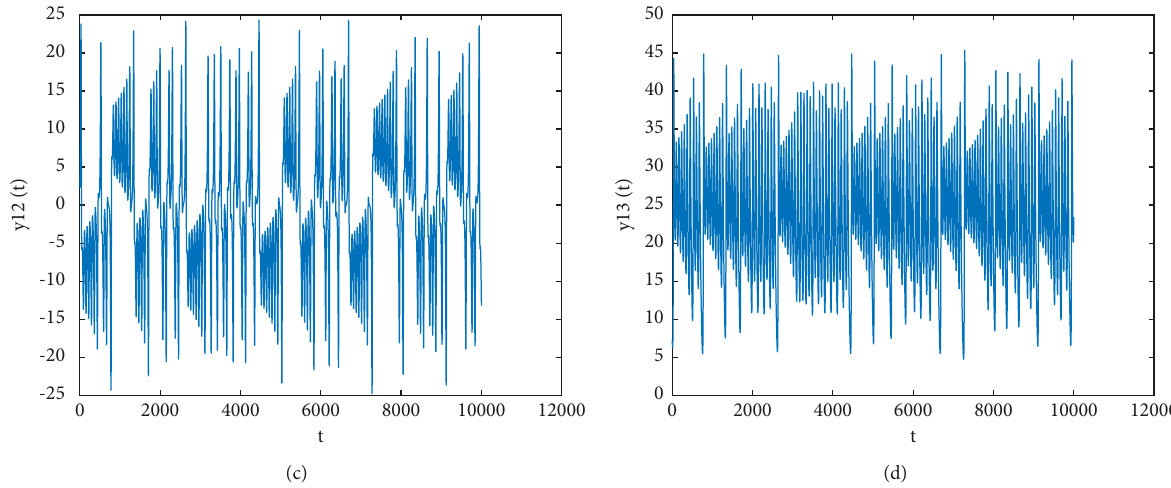
Figure 3: Attractor and time series of the first node of the response system. (a) Lorenz attractor. (b) x time series. (c) y time series. (d) z time series.